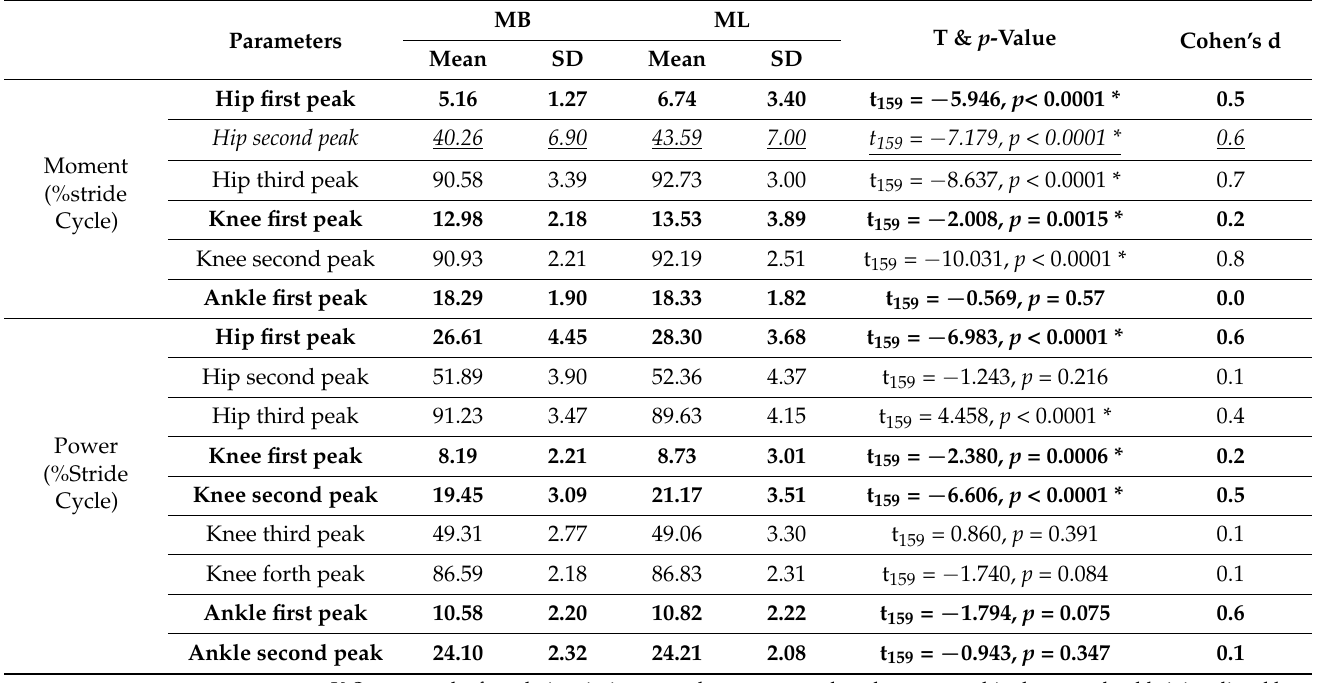
Table 2. Relative Time to Peak as Percentage Stride Cycle (Mean, SD) for Joint moments and Powers for Marker-based (MB) and Markerless (ML)